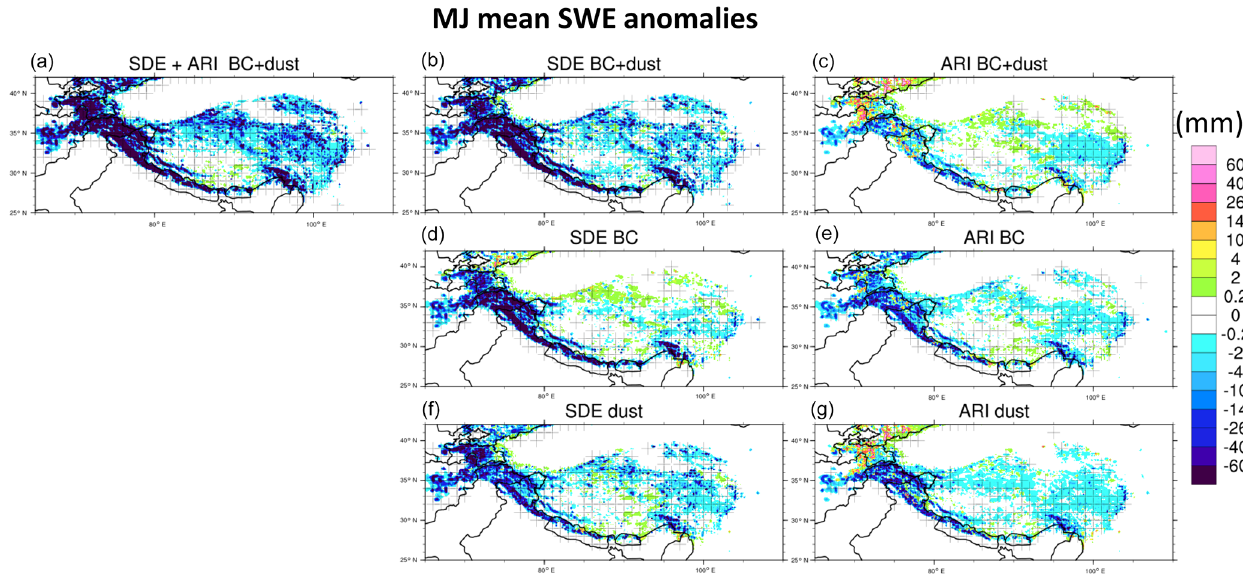
Figure 8. Same as in Fig. 6, but for snow water equivalent (SWE)